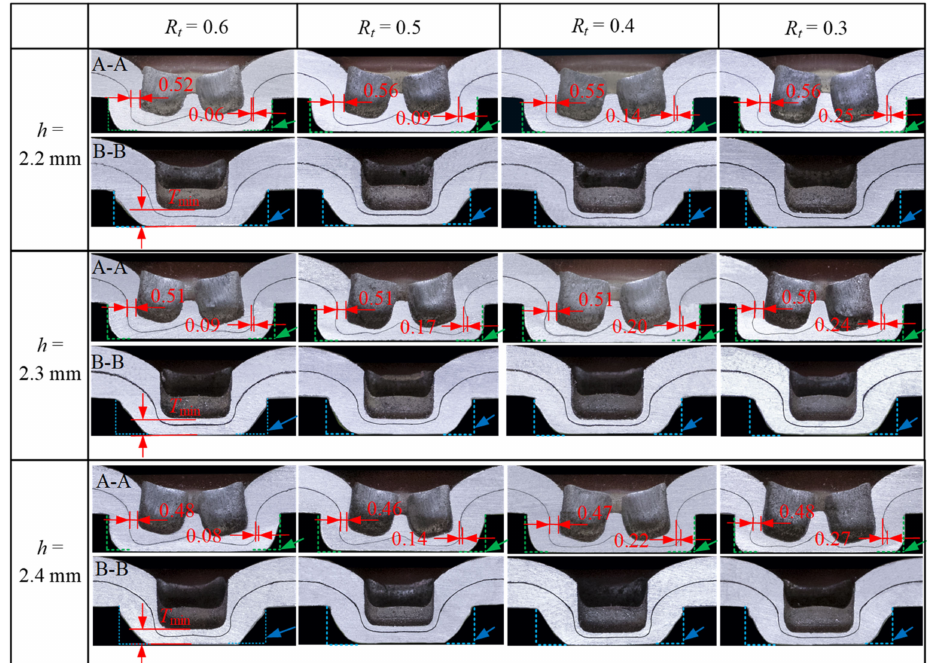
Figure 10. Cross-sectional geometries of joints of sheet thickness t = 1.5 mm at three die depths h and the four values of R t .